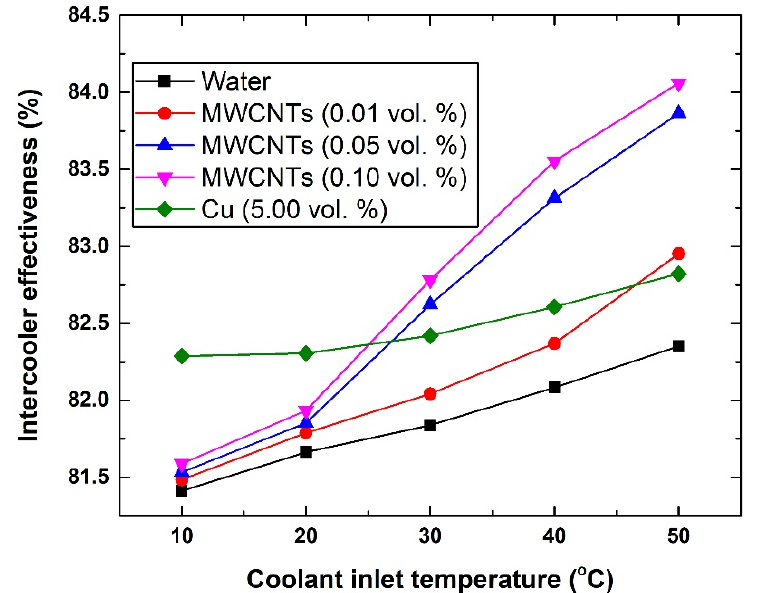
Figure 6 . Changes in intercooler effectiveness with respect to coolants inlet temperature. Figure 6. Changes in intercooler effectiveness with respect to coolants inlet